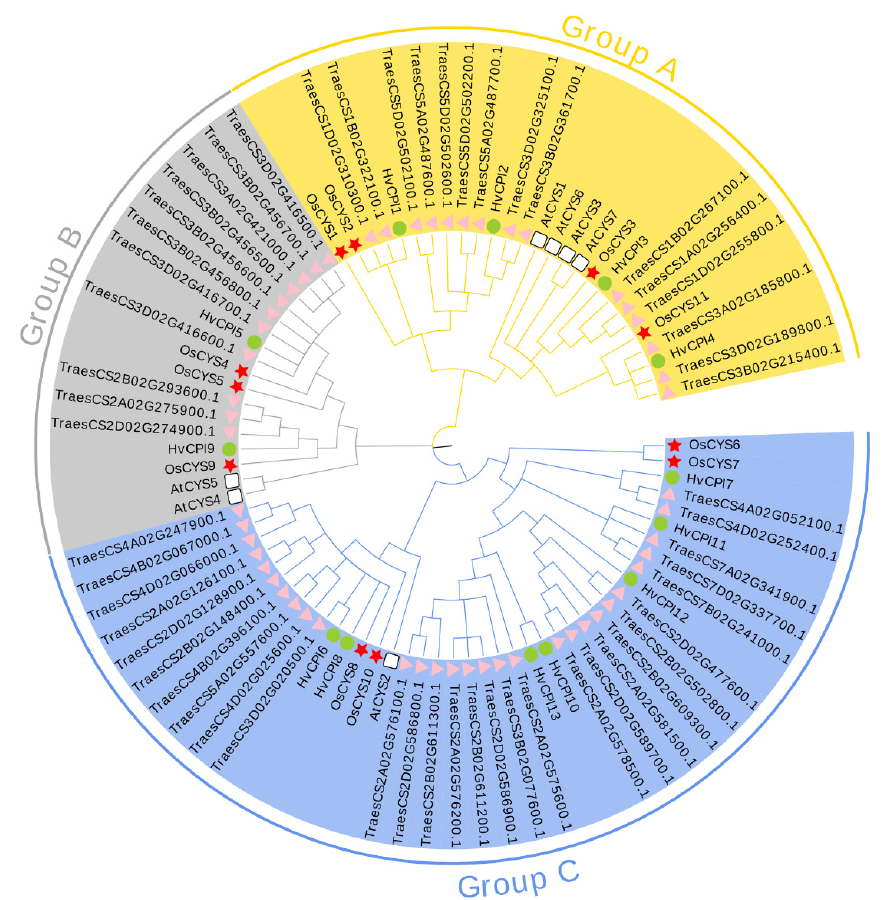
Figure 1. Phylogenetic tree of cystatins. The maximum likelihood (ML) tree was constructed on the basis of the full-length amino acid sequences of bread wheat (55), Arabidopsis thaliana (7), rice (11), and barley (13) using MEGA X software, with a set of 1000 replications. All cystatins were divided into three phylogenetic groups, and each group is represented by a different color. Triangles, stars, circles, and squares correspondingly indicate bread wheat, rice, barley, and A. thaliana .